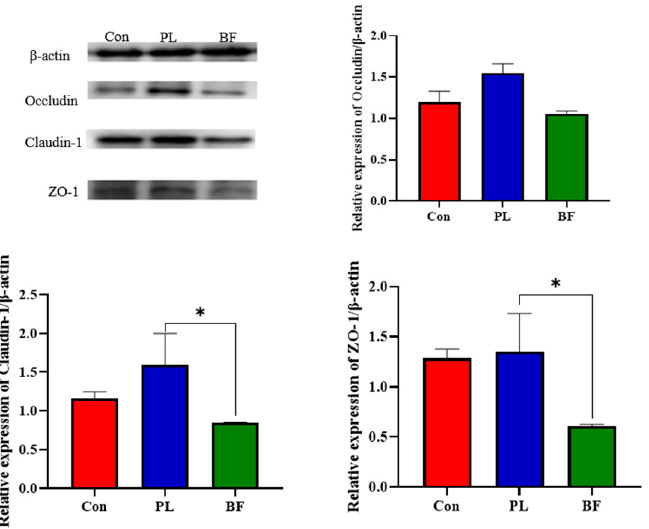
Figure 3. Effect of L. plantarum Y42 in the planktonic and biofilm states administration on the TJ proteins expression in the HT-29; *: p < 0.05. All data are presented as mean ± SD. Note: Con means control group; PL means planktonic group; BF means biofilm group.